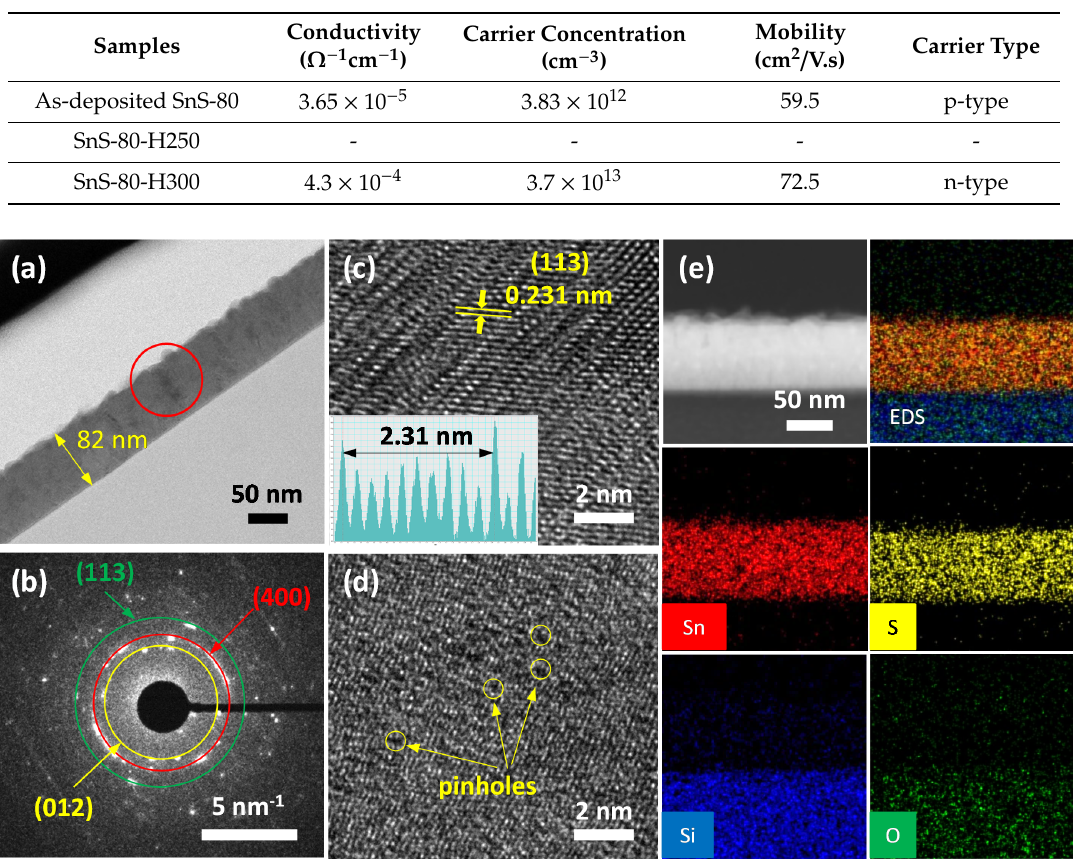
Figure 6. ( a ) TEM image of a SnS-80-H300 thin film on a glass substrate. ( b ) SAED trace of the selected region in (a) demonstrating the polycrystalline structure of the thin film. High-resolution TEM images of different regions ( c ) without and ( d ) with pinholes. The inset in (c) shows the distance between (113) lattice plane fringes. ( e ) Elemental mapping results for a SnS-80-H300 thin film on a glass substrate.